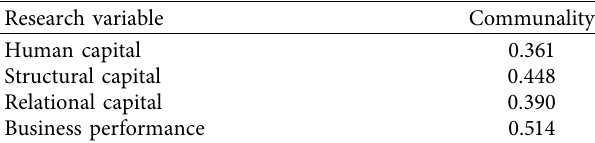
Table 9: Average of common